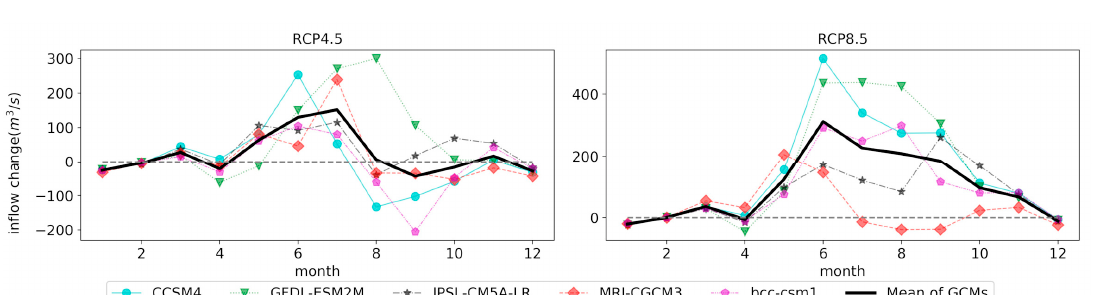
Figure 4. The projected monthly inflow changes in Gongguoqiao between projected 2020–2100 monthly average and historical 1961–2016 monthly average.